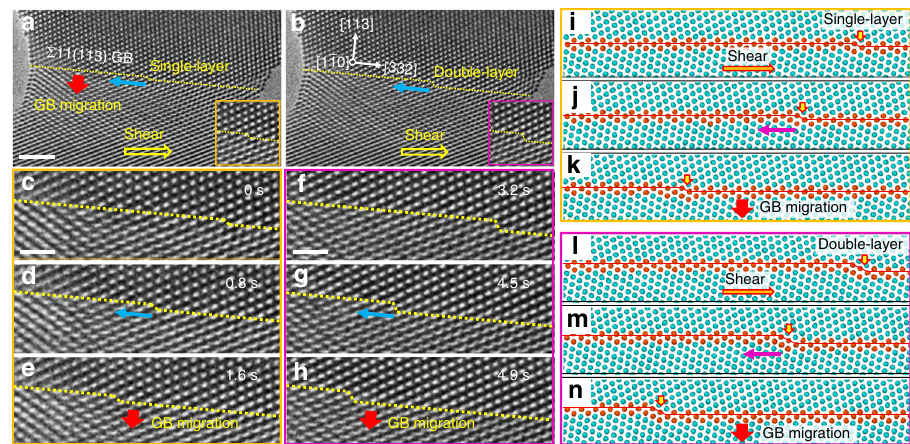
Fig. 2 Atomistic mechanism of GB migration through the lateral motion of single-layer and double-layer disconnections. a , b Typical single-layer ( a ) and double-layer ( b ) disconnections observed during the migration of Σ 11(113) GB. The directions of shear stress, disconnection motion and GB migration are indicated with the yellow, blue and red arrows, respectively. Insets in ( a , b ) show the core structures of corresponding disconnections. c – h Deformation snapshots further reveal the atomistic mechanism of GB migration due to the lateral motion of single-layer ( c – e ) and double-layer ( f – h ) disconnections, respectively. The direction of disconnection motion was opposite to that of the shear stress, with the average motion rates of single-layer and double-layer disconnections measured to be 1.96 nm s − 1 and 2.42 nm s − 1 , respectively. i – n Molecular dynamic (MD) simulation shows lateral motion of single-layer ( i – k ) and double-layer ( l – n ) disconnections coupled to the continuous migration of the Σ 11(113) coherent GB. The directions of shear stress, disconnection motion and GB migration are marked out by the orange, purple and red arrows, respectively. The simulations were performed at 300 K with a shear stress applied to the bottom grain. The disconnections are pointed out by the yellow arrows in each snapshot for clear demonstration of their continuous motion. Scale bars: ( a ) 2 nm, ( c ) and ( f ) 1